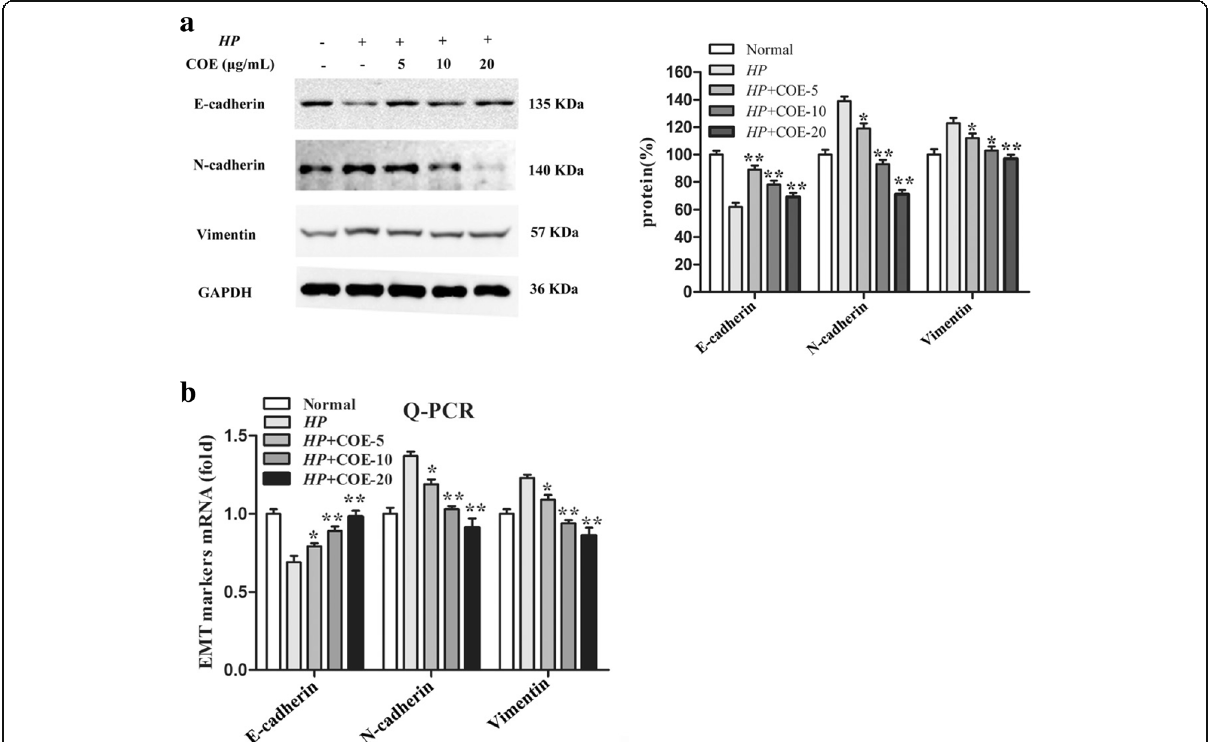
Fig. 2 Effect of COE on H. pylori infection-induced EMT-related gene expression. ( a ) Protein expression levels of E-cadherin, N-cadherin and vimentin were evaluated by western blot. GAPDH was served as an internal control of protein level. The relative density of EMT markers was normalized to GAPDH, which was determined by densitometric analysis. ( b ) Relative mRNA levels of EMT-related gene were examined by RT-PCR. The data was analyzed using the 2 - ΔΔ Ct method. Each experiment from three independent experiments and values are expressed as means ± SD of three independent experiments. * P < 0.05, ** P < 0.01, compared to H. pylori infection-induced